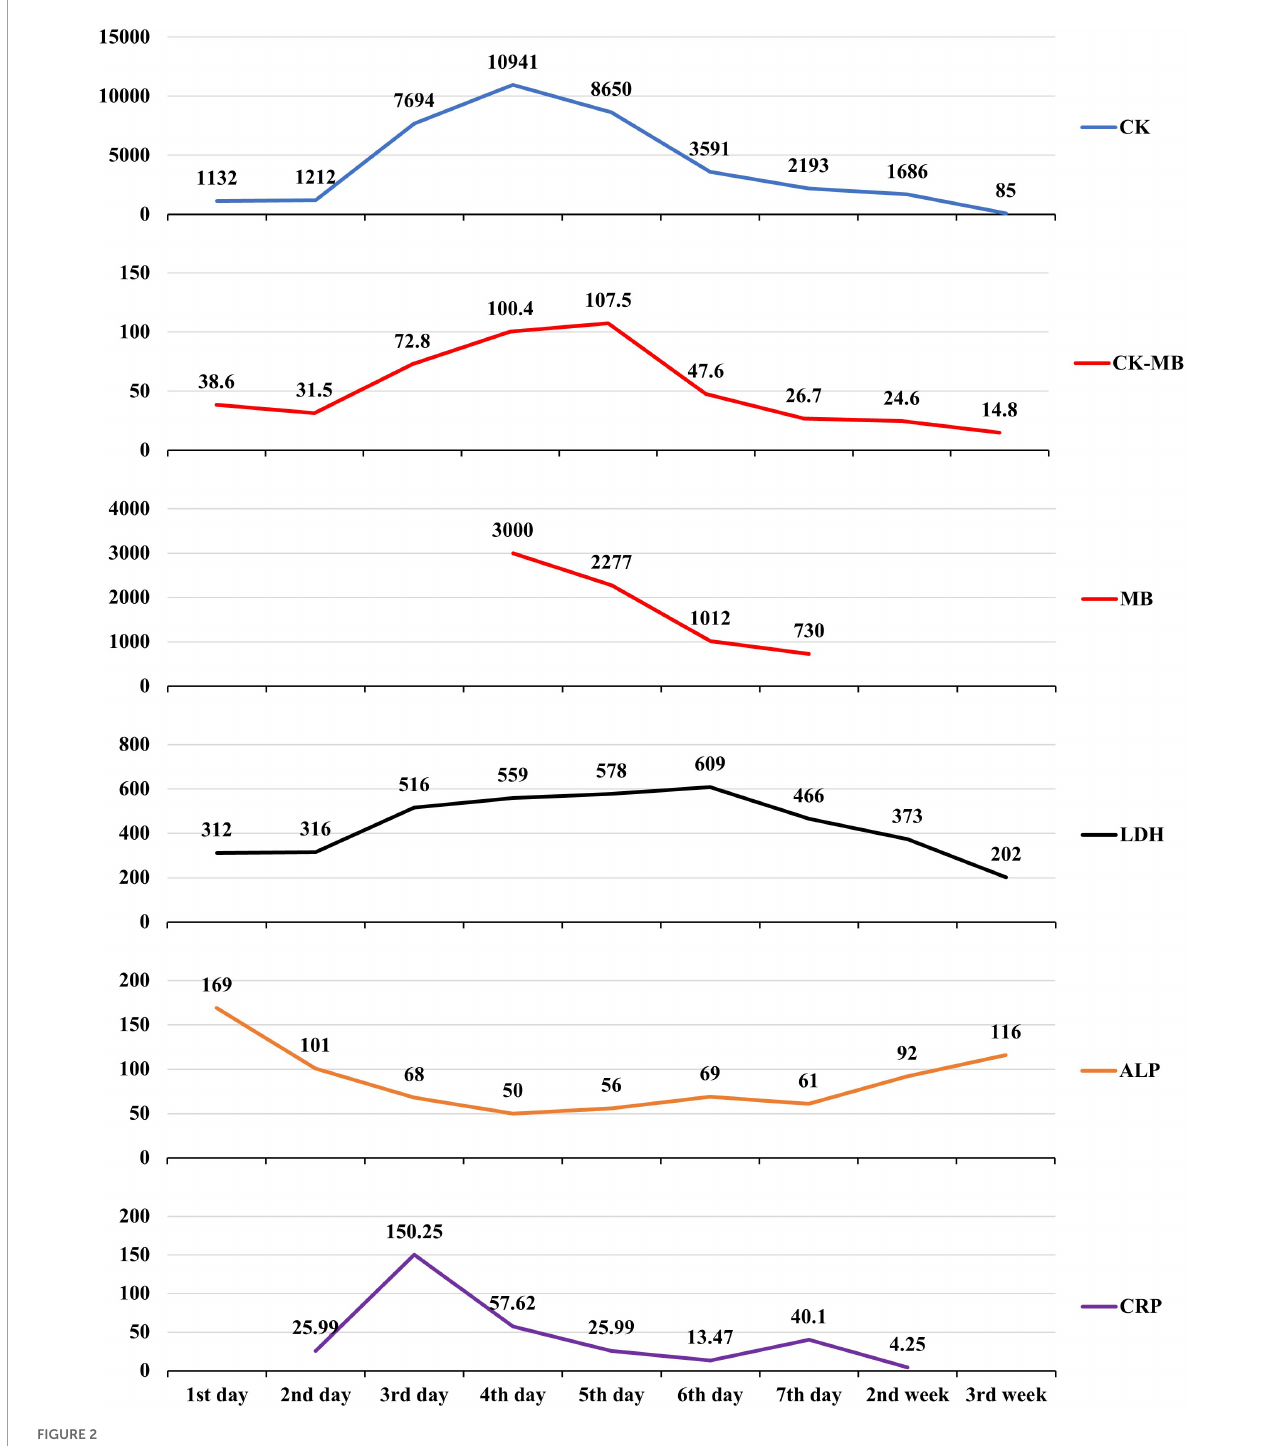
FIGURE2 Changes in the patient’s main laboratory test results during admission.